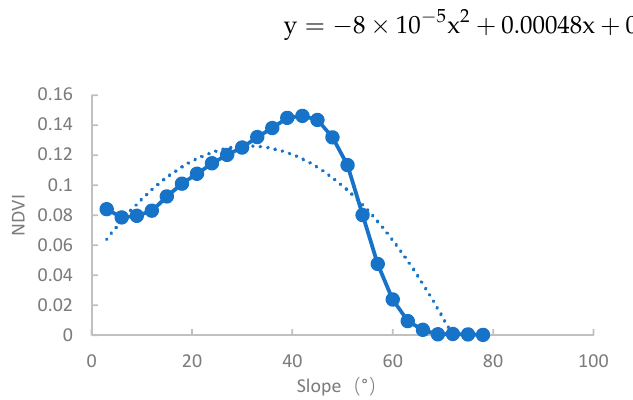
Figure 9. Relationship between vegetation damage and slope.